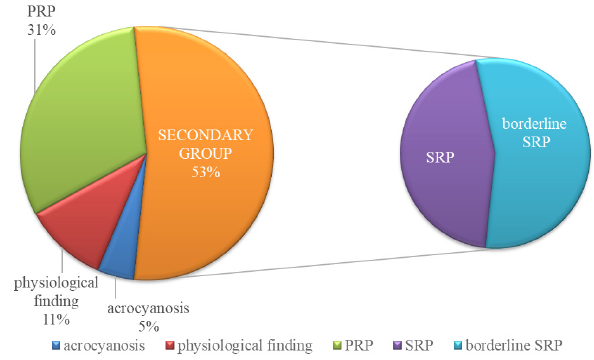
Fig. 6. Distribution of groups of findings according to the IRT results and capillaroscopic